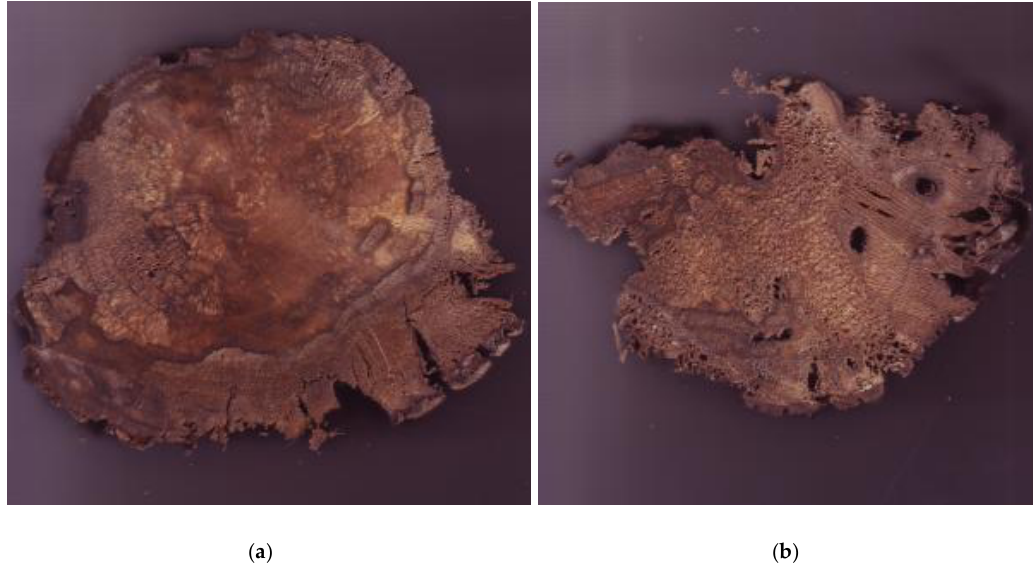
Figure 5. Cross-sections of typical (representative) samples of alder wood from section LW of the forest road in Chmiel Forest District of the Lutowiska Forest Inspectorate: (a) sample no. Ols2-LW, (b) sample no. Ols3-LW,